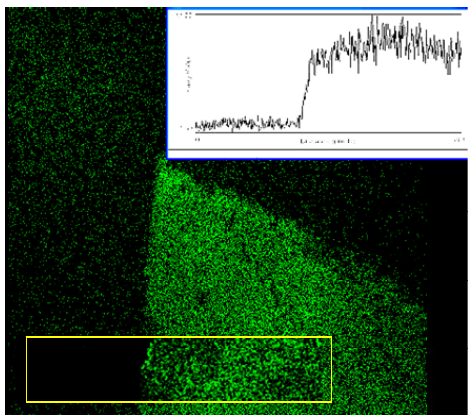
Figure 6. The profile of the enhancement factor for 47 nm Ag coated Au colloid